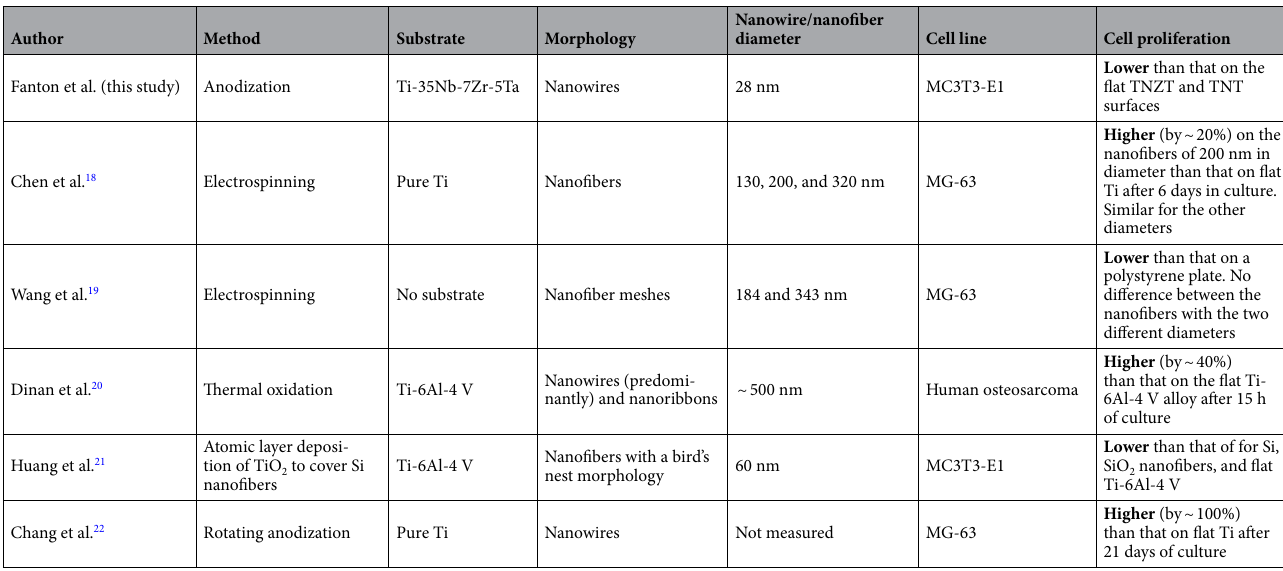
Table 1. Studies of bone cell behavior on surfaces covered with TiO 2